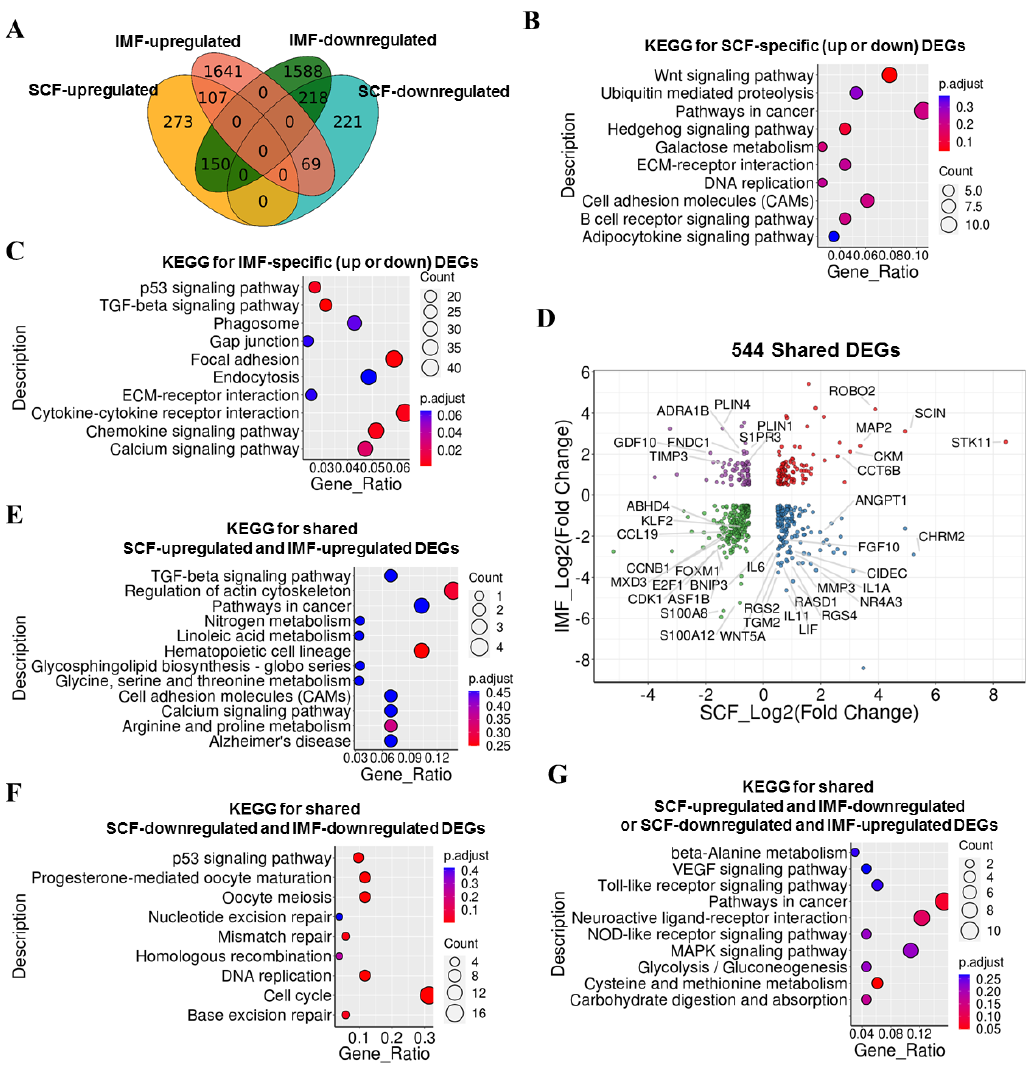
Figure 5. Comparison of LKB1-induced DEGs in IMF and SCF adipocytes. ( A ) Venn diagram of LKB1-induced DEGs in IMF and SCF adipocytes, which were further divided into upregulated DEGs in SCF adipocytes, downregulated DEGs in SCF adipocytes, upregulated DEGs in IMF adipocytes, downregulated DEGs in IMF adipocytes. ( B , C ) Functional enrichment analyses using KEGG pathways of SCF adipocyte-specific DEGs (273 upregulated DEGs and 221 downregulated DEGs) (B) and IMF adipocyte-specific DEGs (1641 upregulated DEGs and 1588 downregulated DEGs) ( C ). ( D ) Dotplot of 544 shared DEGs in IMF and SCF adipocytes upon LKB1 overexpression. The x -axis indicates log2 (fold change) values of genes in SCF adipocytes, and the y -axis indicates log2 (fold change) values of genes in IMF adipocytes. The shared DEGs were divided into 4 categories: upregulated in both IMF and SCF adipocytes (red), downregulated in both IMF and SCF adipocytes (green), upregulated in IMF adipocytes and downregulated in SCF adipocytes (blue), and downregulated in IMF adipocytes and upregulated in SCF adipocytes (purple). ( E – G ) Functional enrichment analyses using KEGG pathways of upregulated shared DEGs in both IMF and SCF adipocytes ( E ), downregulated shared DEGs in both IMF and SCF adipocytes ( F ), and inversely regulated shared DEGs ( G ).